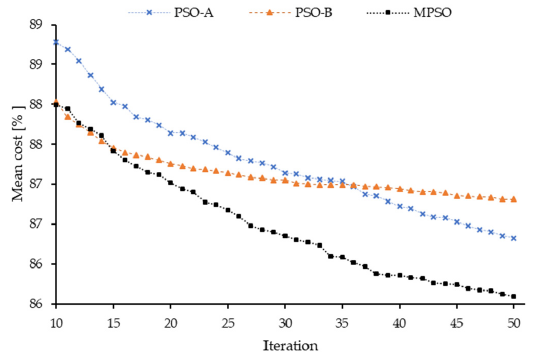
Figure 10. Mean convergence of optimization from 100 test runs.